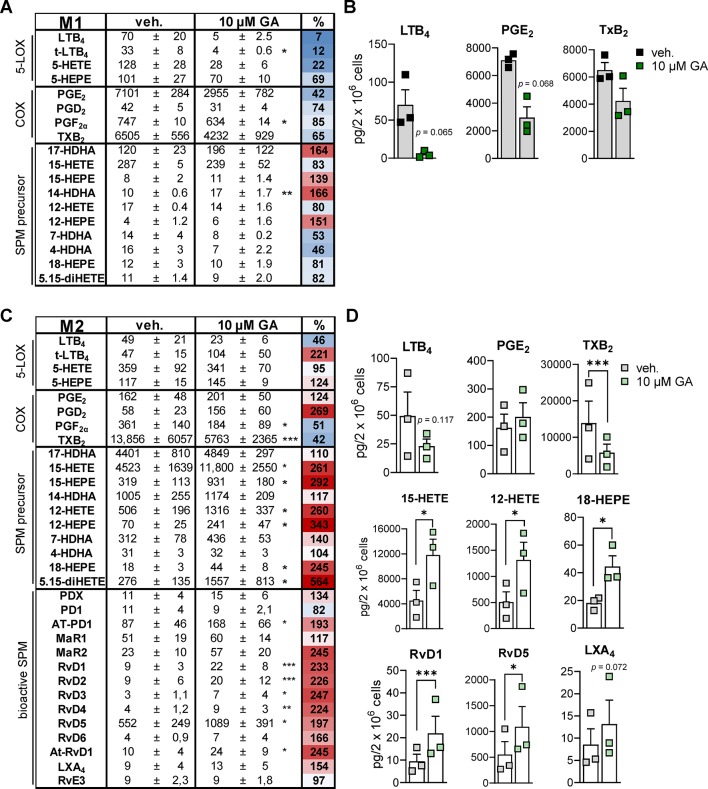
Effects of GA on LM profiles in human M1 and M2 macrophages. Human M1 (A and B) or M2 (C and D) macrophages (2 × 106 cells/ml) were preincubated with 10 µM GA or vehicle (0.1% DMSO) for 10 min at 37°C before exposure to pathogenic E. coli (O6:K2:H1; ratio 1:50) for 3 h. LMs were extracted by SPE and analyzed by UPLC-MS-MS. (A and C) Means ± SEM are shown, and the heat map represents the percentage of vehicle-treated cells (=100% control, white; red > 100%; blue < 100%); n = 3. (B) Effects of GA on LTB4, PGE2, and TXB2 biosynthesis in M1, shown as pg/2 × 106 cells; SPM were below detection limit (<0.5 pg). (D) Effects of GA on LTB4, PGE2, TXB2, 15-HETE, 12-HETE, 18-HEPE, RvD1, RvD5, and LXA4 biosynthesis in M2, shown as pg/2 × 106 cells. Data were log-transformed for Student’s paired t test; *p < 0.05, **p < 0.01, and ***p < 0.001 vs. vehicle (DMSO) control.